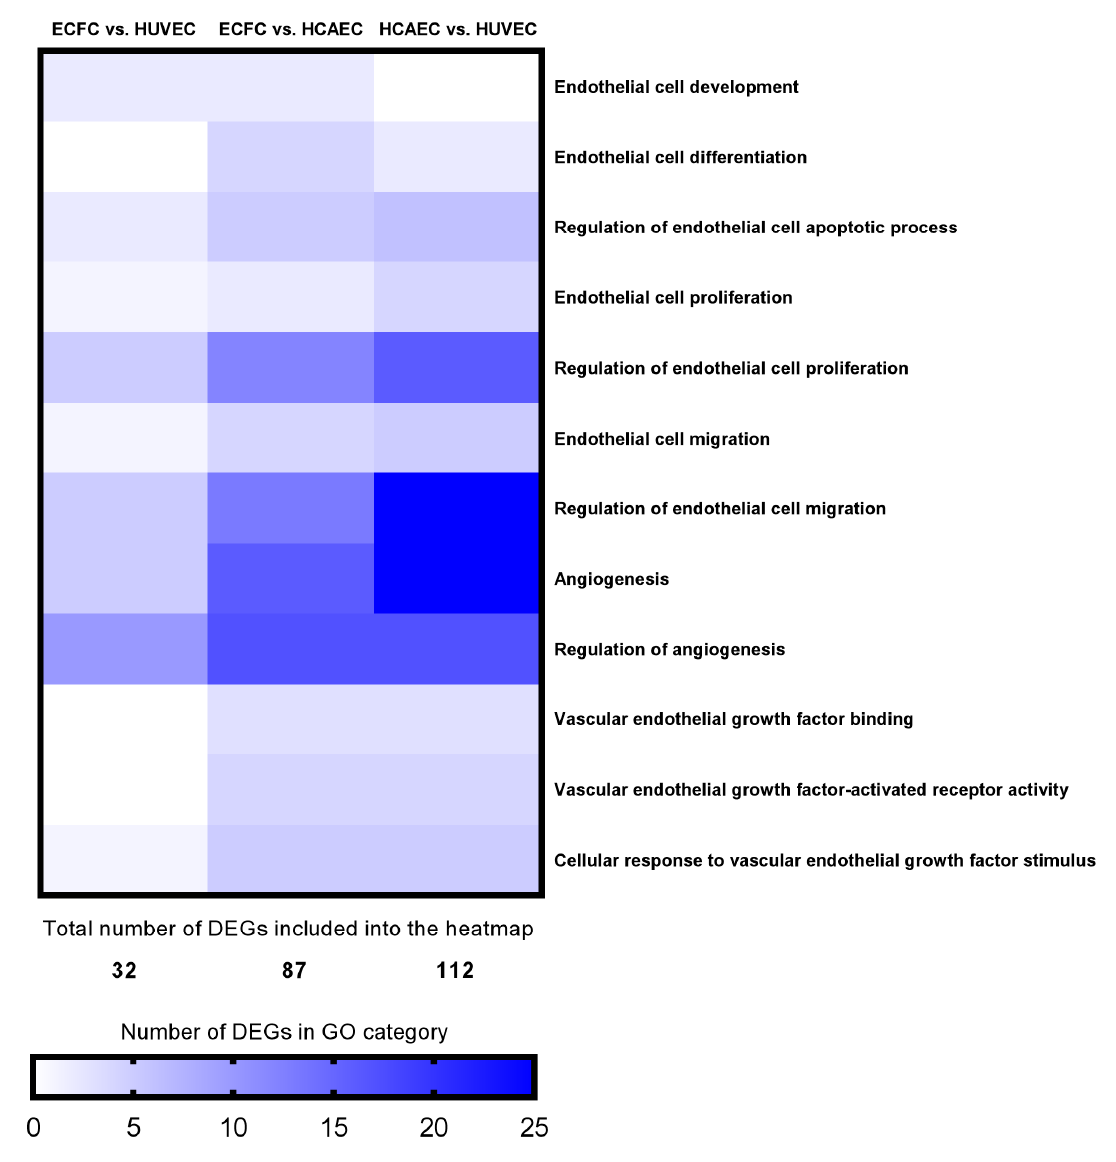
Figure 5. Heatmap representing the genes related to the regulation of endothelial homeostasis and angiogenesis and differentially expressed between ECFC, HCAEC, and HUVEC according to the GO functional enrichment analysis. Top panel: pairwise comparisons between the EC populations. Right panel: GO terms manually included in the heatmap. Bottom panel: a color mapping range.